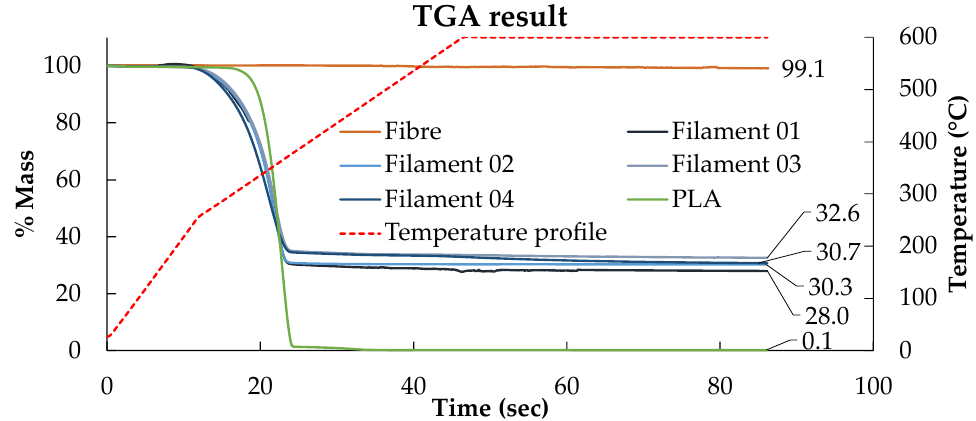
Figure 4. TGA programme to investigate fibre weight fraction by considering residual fibre content after matrix burn-off showing the fibre, DcAFF (HiPerDiF-PLA) composite, and PLA with the tem- perature profile (red line).